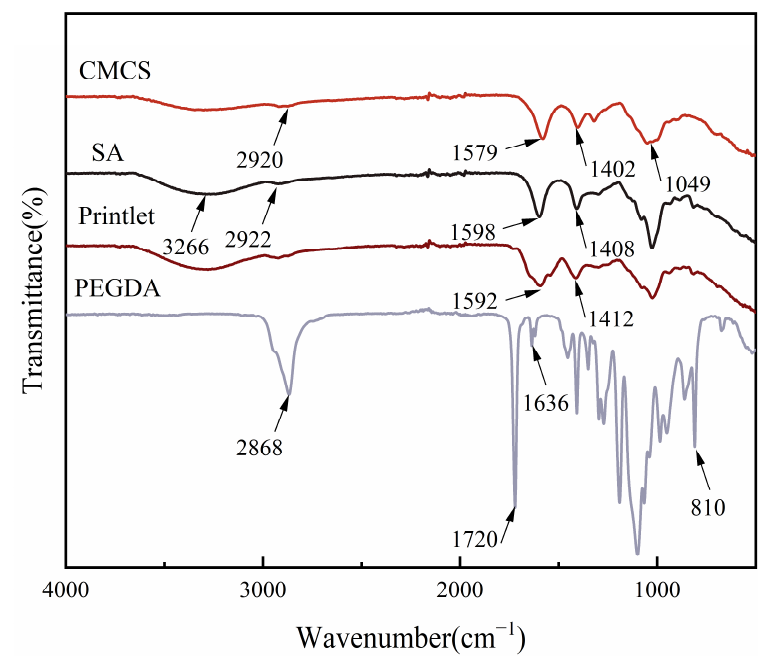
Figure 8. FTIR spectra of BSA, CMCS, SA, Printlet, and